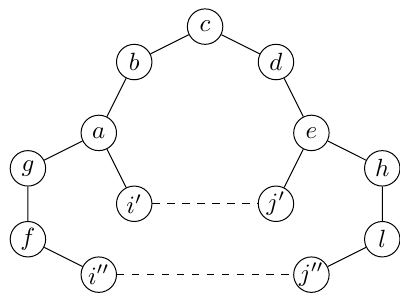
Figure 2 Cycles C ( i 0 , j 0 ) and C ( i 00 , j 00 ) partially overlap: since [ i 0 , j 0 ] is cheaper than [ i 00 , j 00 ],